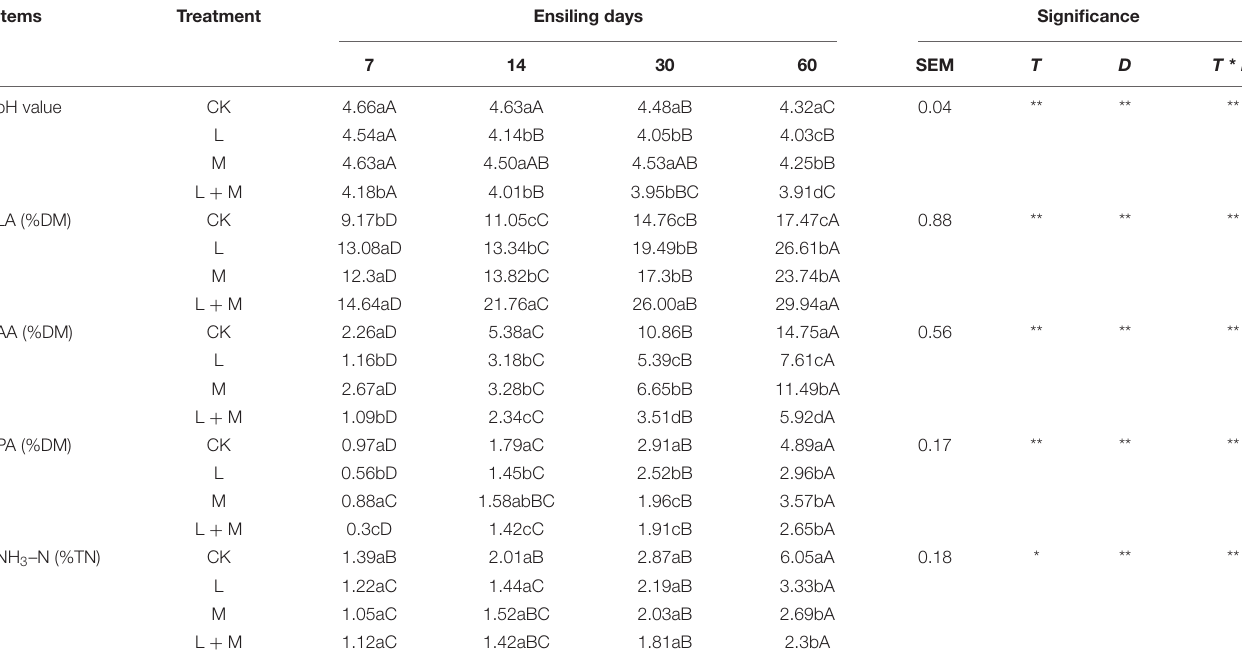
TABLE 3 | Effect of additives and ensiling days on fermentation quality of native grass silages. Items Treatment Ensiling days